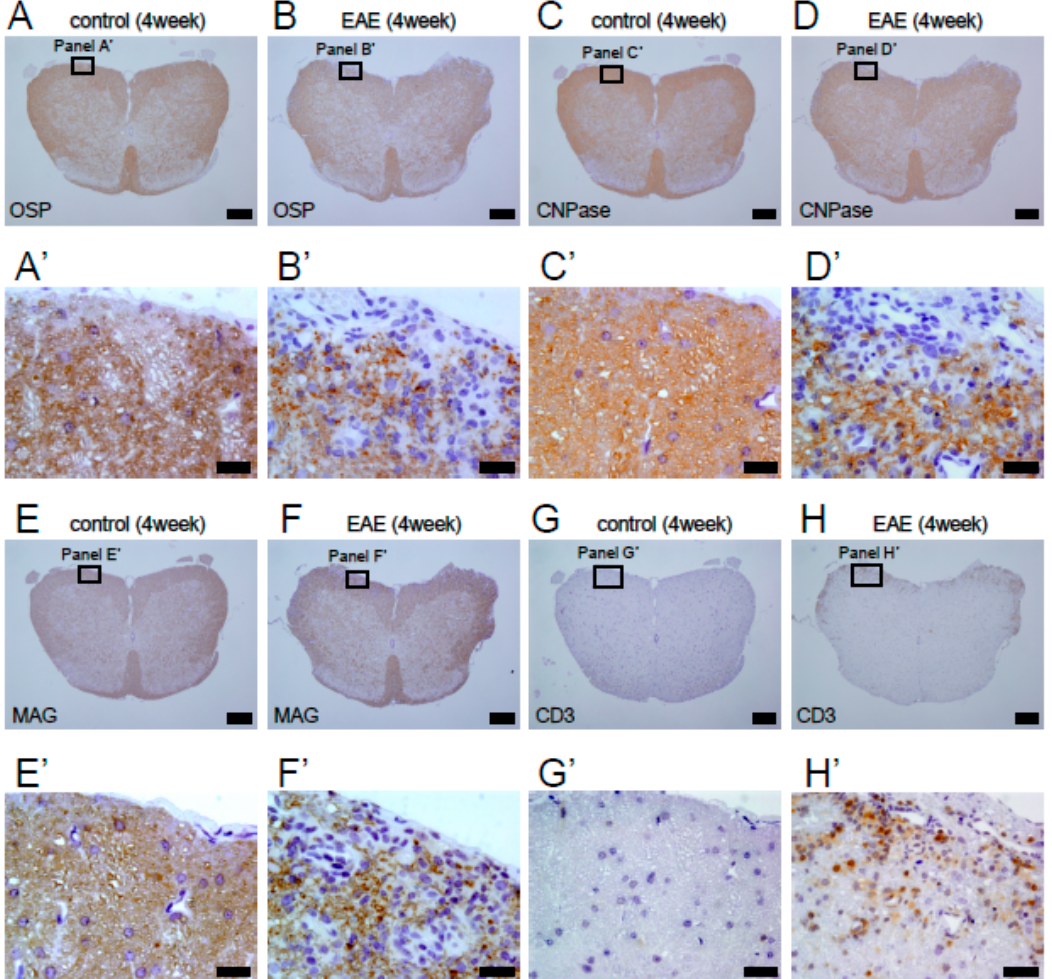
Figure 3. Immunohistochemistry of lumbar spinal cord sections obtained from control ( A , A’ , C , C’ , E , E’ , G , and G’ ) and MOG-immunized mice ( B , B’ , D , D’ , F , F’ , H , and H’ ) 4 weeks after treatment. Immunohistochemistry for OSP ( A , A’ , B , and B’ ), CNPase ( C , C’ , D , and D’ ), and MAG ( E , E’ , F , and F’ ) showed that, although control mice widely expressed these oligodendrocyte markers throughout the spinal cord, EAE mice frequency had lost these markers, mainly in the injured white matter. Immunohistochemistry for CD3 showed that, although infiltration of CD3 + lymphocytes was rarely observed in control mice ( G , G’ ), accumulation of many CD3 + lymphocytes was observed predominantly in damaged white matter regions in EAE mice ( H , H’ ). Results displayed are representative of three replicates ( N = 3). Scale bars = 200 µ m ( A – H ) and 20 µ m ( A’ – H’ ). Abbreviations: MOG, myelin oligodendrocyte glycoprotein; OSP, oligodendrocyte-specific protein; MAG, myelin- associated glycoprotein; EAE, experimental autoimmune encephalomyelitis.